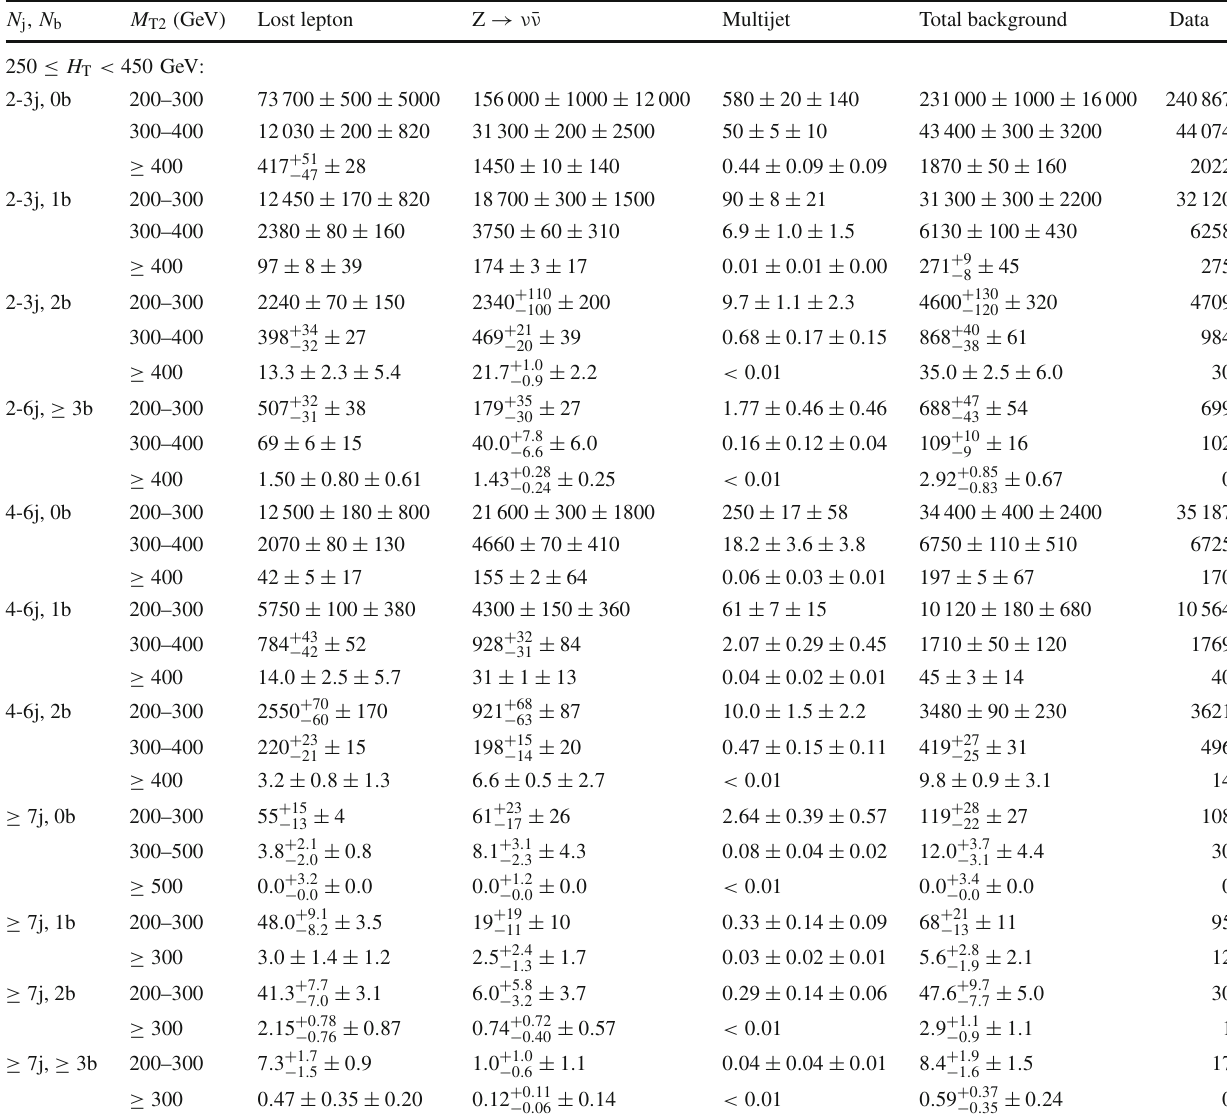
Table 13 Predictions and observations for the 30 search regions with 250 ≤ H T < 450 GeV. For each of the background predictions, the first uncertainty listed is statistical (from the limited size of data control samples and Monte Carlo samples), and the second is systematic